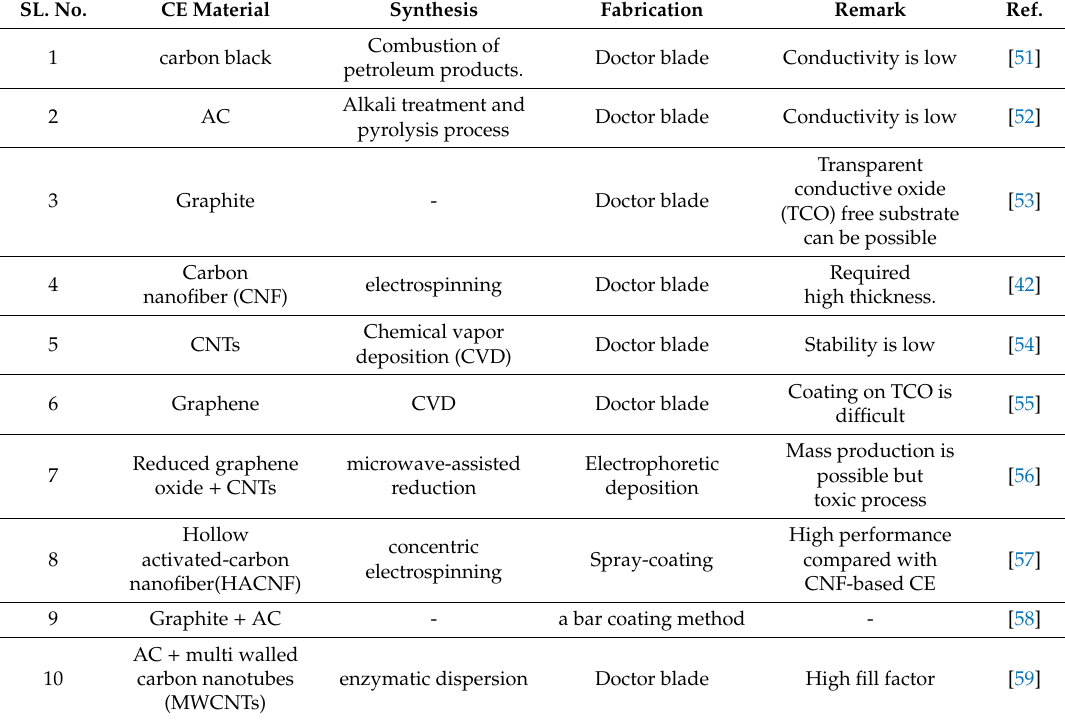
Table 1. Synthesis and fabrication methods of di ff erent carbon-based counter electrodes. SL.